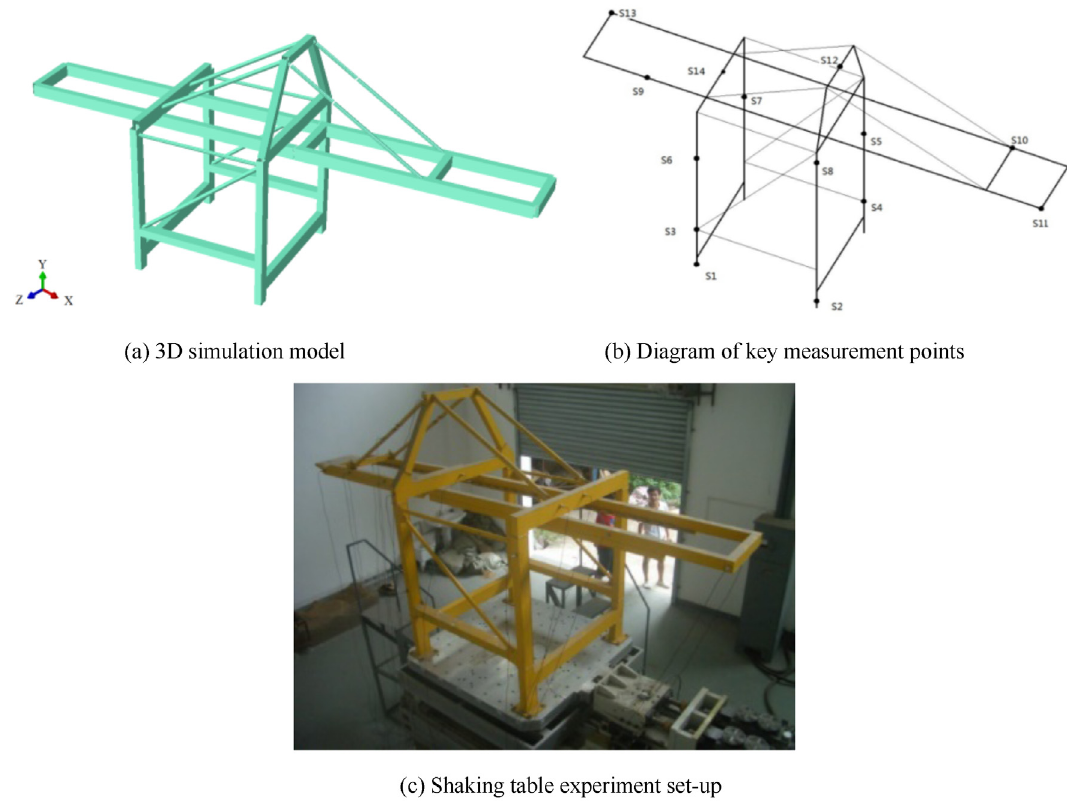
Fig. 2. 3D simulation model and experiment